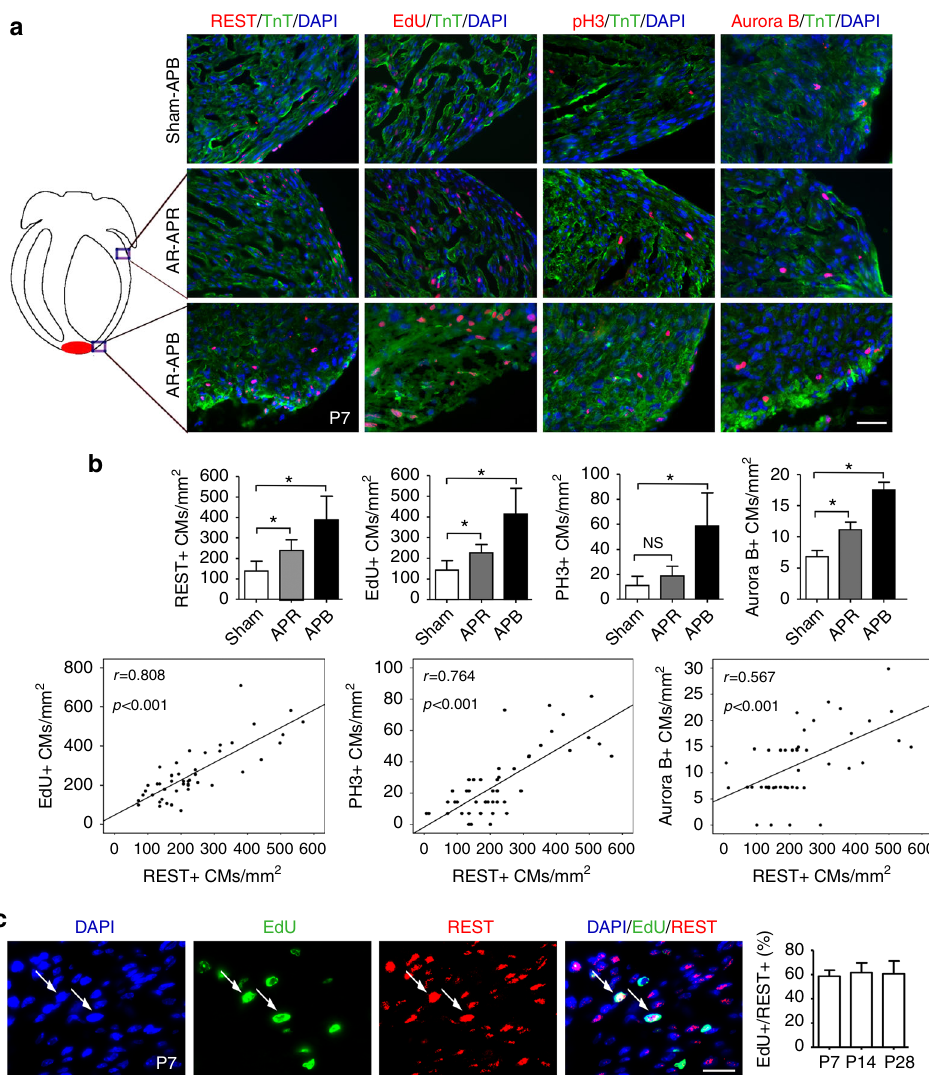
Fig. 6 Co-upregulation of REST and cardiomyocyte proliferation in injured neonatal hearts. a , b Quantitative immuno fl uorescence ( a Scale bar = 40 μ m.) and scatter plot b showing increased expression of REST and its positive relation with the expression of cell cycle markers in cardiomyocytes. Average counts from six fi elds/section, four sections/ventricle, four ventricles/stage at P7, P14, and P28, mean ± s.d. * p < 0.05 by one-way ANOVA followed by Tukey ’ s test. APB/APR apex border/apex remote. c Co-immuno fl uorescence showing consistently ~60% of EdU+ cells express REST (arrow) in regenerating neonatal hearts. Scale bar = 10 μ m. Data are presented as mean ± s.d. ( n =